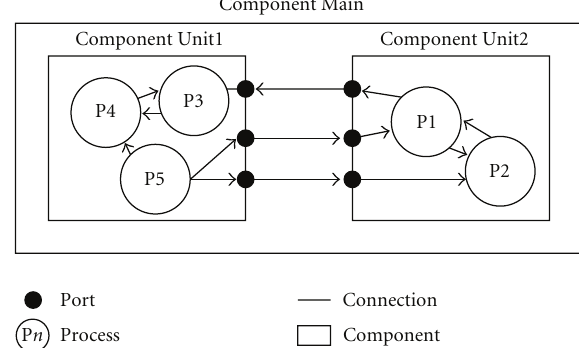
Figure 4: Example of a model with three components. The top hierarchy is the component Main that encapsulates two subcompo- nents Unit 1 and Unit 2 . Internal activities of each subcomponent communicate through the ports of the interfaces.